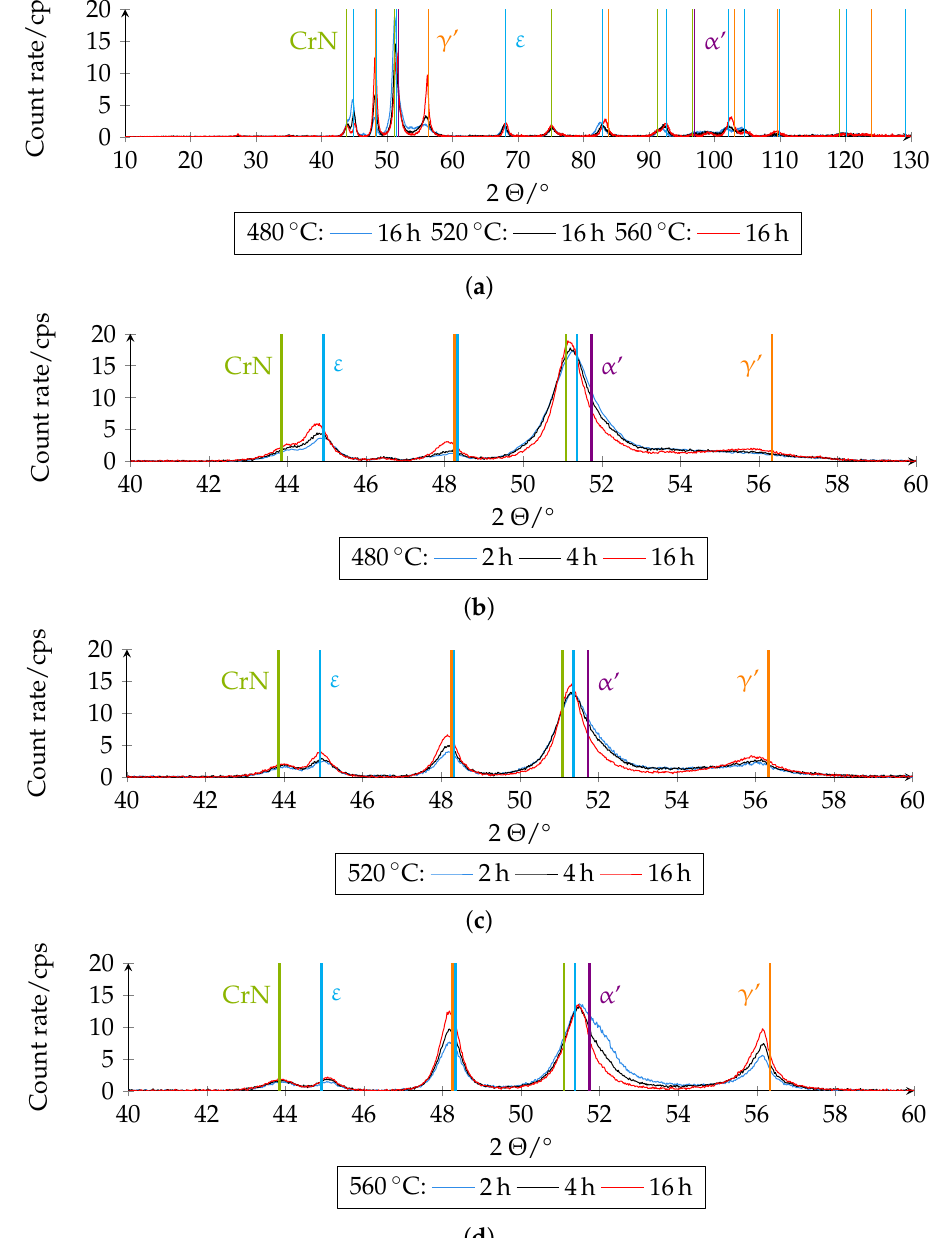
Figure 19. () shows an example of the diffractograms from 10 ◦ to 130 ◦ for the different plasma nitriding temperatures at 16h plasma nitriding time. For a better overview Figures () to () each show a section of the diffractogram from 40 ◦ to 60 ◦ of samples plasma nitrided at different temperatures with different durations. ( a ) Section of diffractogram from 10 ◦ to 130 ◦ of samples plasma nitrided at different temperatures and with a duration of 16 h. ( b ) Section of diffractogram from 40 ◦ to 60 ◦ of samples plasma nitrided at 480 ◦ C. ( c ) Section of diffractogram from 40 ◦ to 60 ◦ of samples plasma nitrided at 520 ◦ C. ( d ) Section of diffractogram from 40 ◦ to 60 ◦ of samples plasma nitrided at 560 ◦